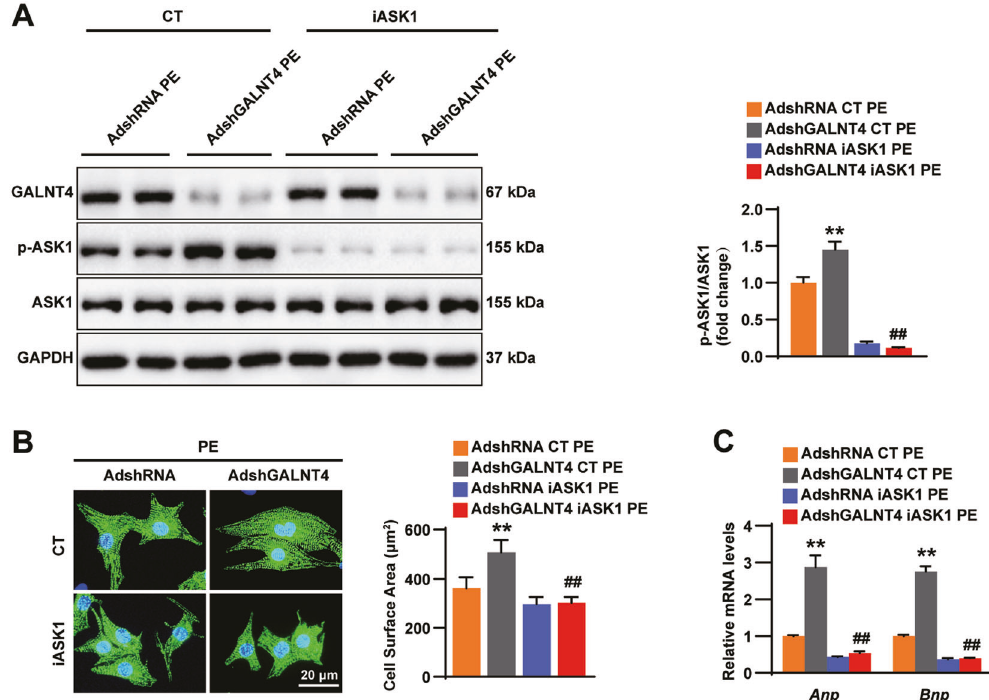
Fig. 7 Inhibiting ASK1 is the key step by which GALNT4 regulates hypertrophy. A The protein levels of GALNT4, pASK1, and ASK1 in NRCMS infected with the indicated adenovirus and treated with iASK1 or not after treatment with PE. B Images of NRCMS in each group and the CSA ( n = 30-40 cells). C The mRNA expression levels of ANP and BNP were examined by RT qPCR. n = 3 independent experiments. ** p < 0.01 vs. AdshRNA, ## p < 0.01 vs.